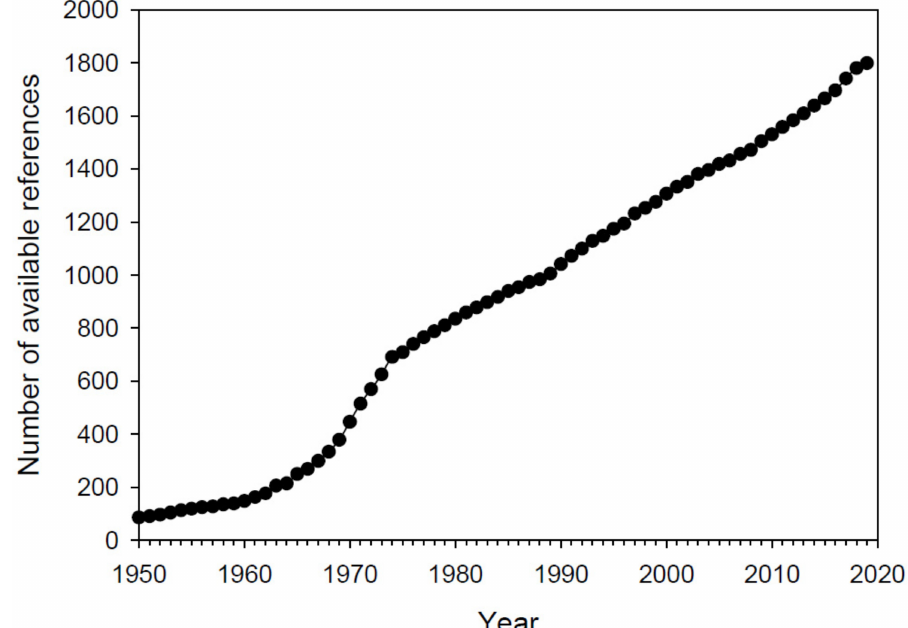
Figure 1. Cumulative number of available references related to atomic energy levels for neutral, singly-, doubly- and triply-ionized lanthanides taken from the NIST bibliographic database [1].